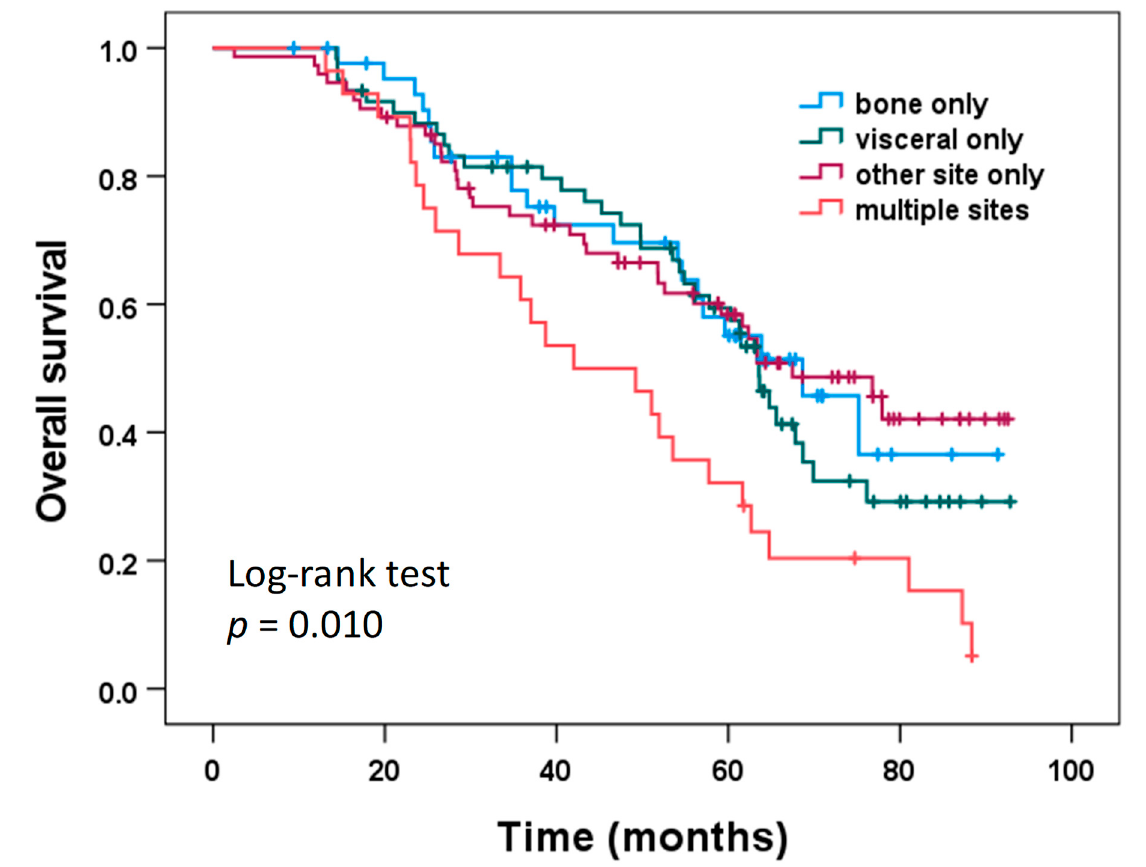
Figure 2. Overall survival according to the site of first metastatic